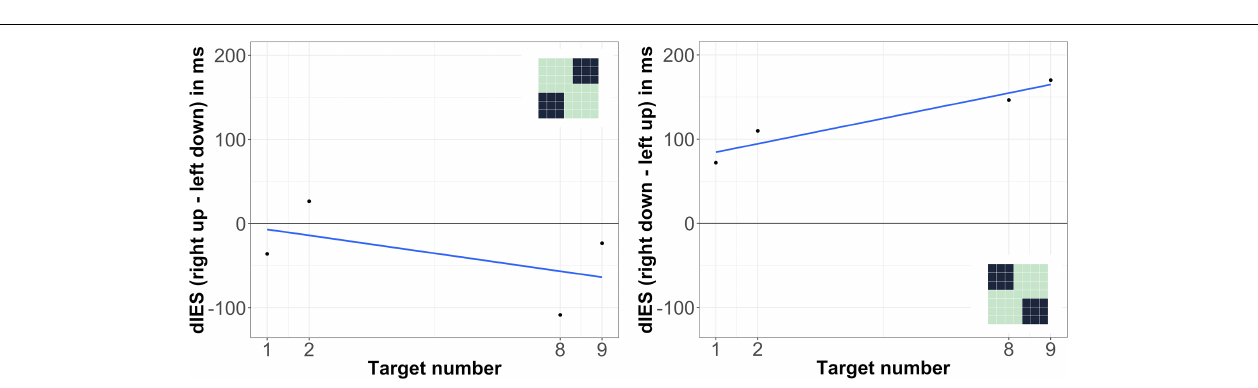
FIGURE 4 | Differences between IES (dIES) when target numbers were presented at different locations on the screen. Left: left down vs. right up presentation, negative values indicate more efficient responses for right upper presentation; right: left up vs. right down presentation, positive values indicate more efficient responses for left upper presentation. The spatial positions within the 7 × 7 grid that were compared against each other in the respective analysis are illustrated as dark areas in the depicted miniature 7 × 7